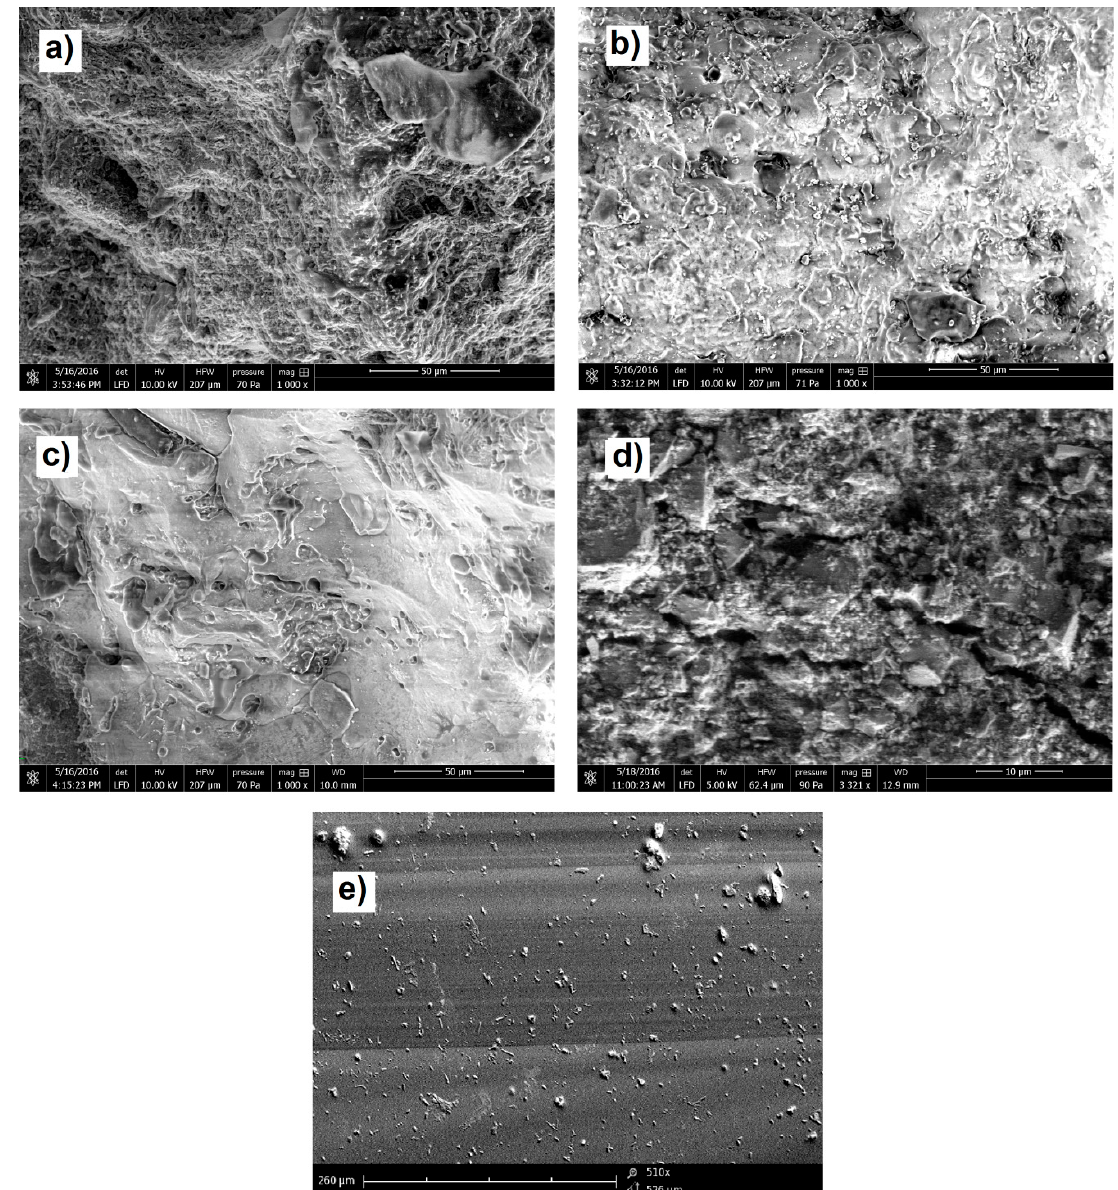
Figure 6. Images of aggregate grain structure: ( a ) obtained from red bricks (magnification 1000 × ), ( b ) glazed ceramics (magnification 1000 × ), ( c ) sanitary ceramics (magnification 1000 × ), ( d ) gravel (3321 × magnification), ( e ) basalt (510 × magnification).